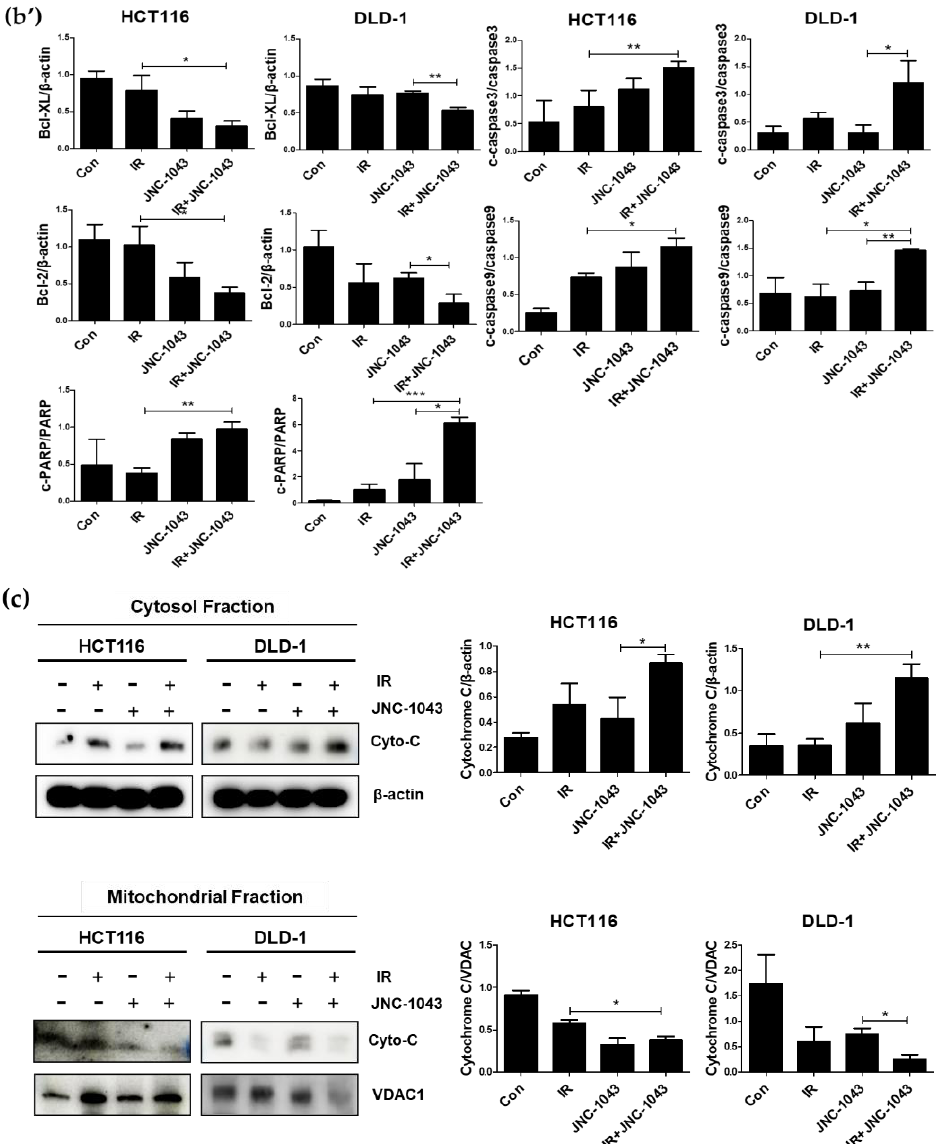
Figure 4. Co-treatment with JNC-1043 and IR induces apoptotic cell death. ( a ) Annexin V-PI assay for detection of apoptosis. HCT116 and DLD-1 cells were treated with 110 or 150 nM JNC-1043, respectively, and 3 Gy IR for 72 h. The assay method is described in the Materials and Methods. The lower panel shows representative FACSort flow cytometry images obtained prior to quantitative analyses. ‘Con’, DMSO-treated mock control; ‘IR’, treatment with 3 Gy IR only; ‘JNC-1043 (cid:48) , treatment with 110 or 150 nM JNC-1043 only; ‘IR+JNC-1043 (cid:48) , combination of 3 Gy IR and 110 or 150 nM JNC- 1043. Experiments were repeated in triplicate, and the results indicate the mean of the triplicate assay. ( b ) Immunoblot assay for detecting Bcl-2, Bcl-XL, cleaved caspase-3 (cas-3), cleaved caspase-9 (cas-9), and cleaved PARP in cells treated with JNC-1043 and IR. ‘c-cas3 (cid:48) , ‘c-cas9 (cid:48) and ‘c-PARP’ indicate the cleaved forms. HCT116 and DLD-1 cells (1 × 10 5 ) were incubated with or without 110 or 150 nM JNC-1043, respectively, exposed to 3 Gy IR, and incubated for 72 h prior to harvest. Each graph under the panel presents the statistical analysis of the immunoblot bands. ( b’ ) The relative band